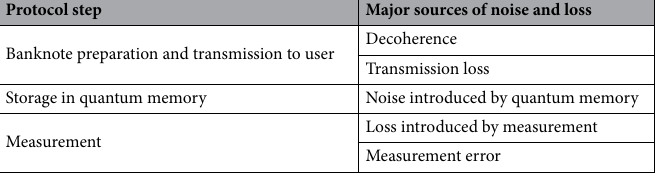
Table 1. Major sources of noise and loss in quantum money